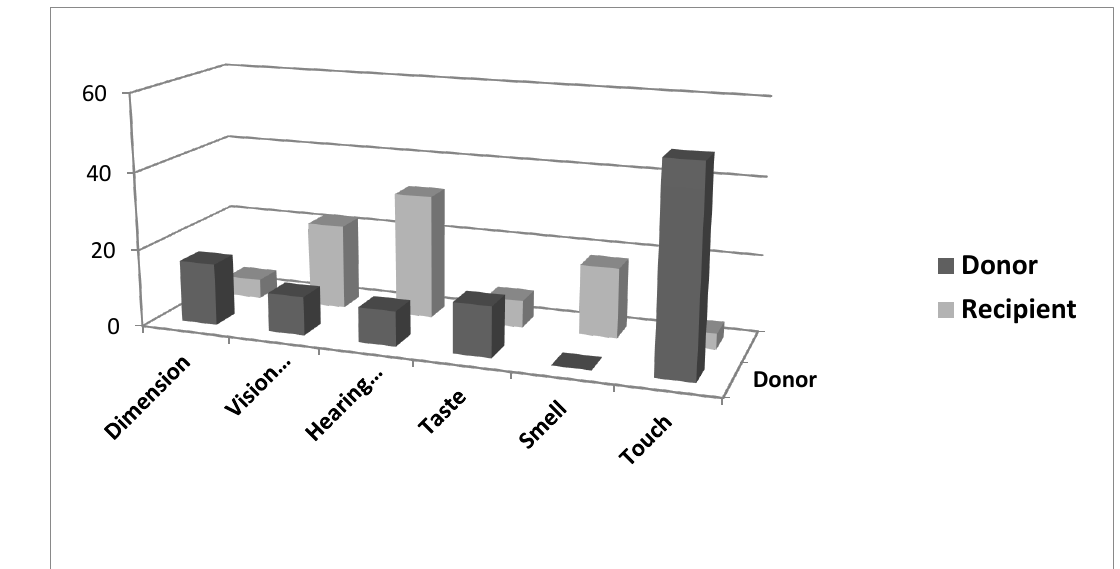
Fig. 3. – Total number of produced and received metaphors for each sensor in the Russian language (five senses plus Dimension Zone) Italian and Russian